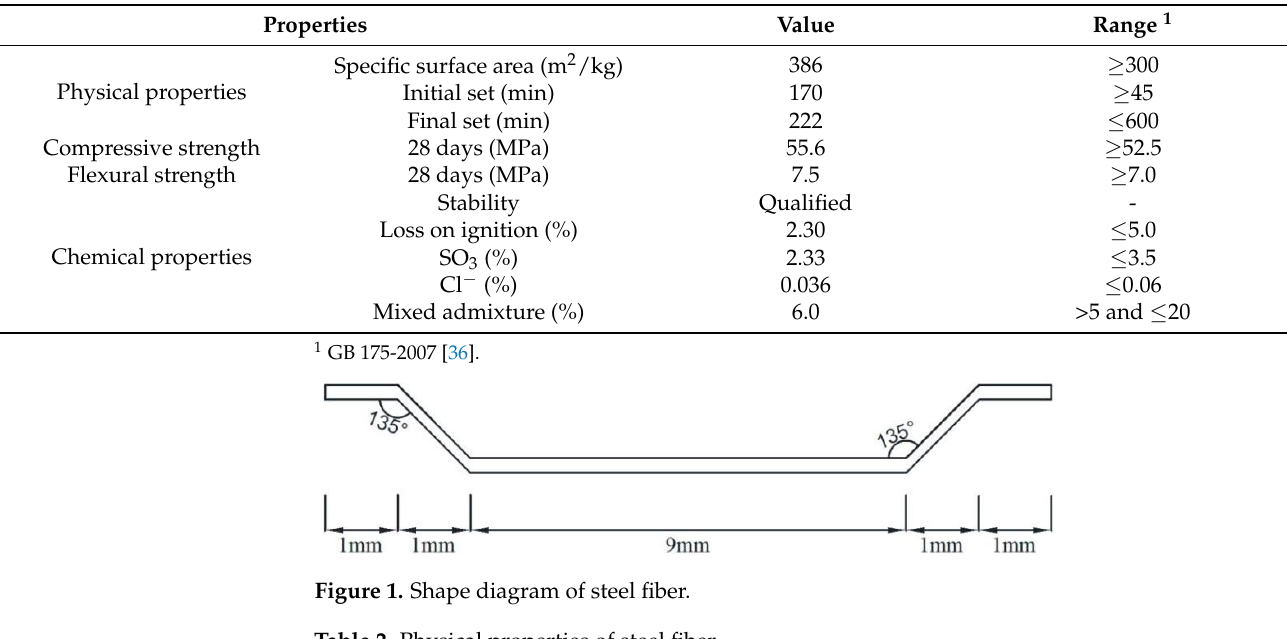
Table 1. Chemical and physical properties of cement.